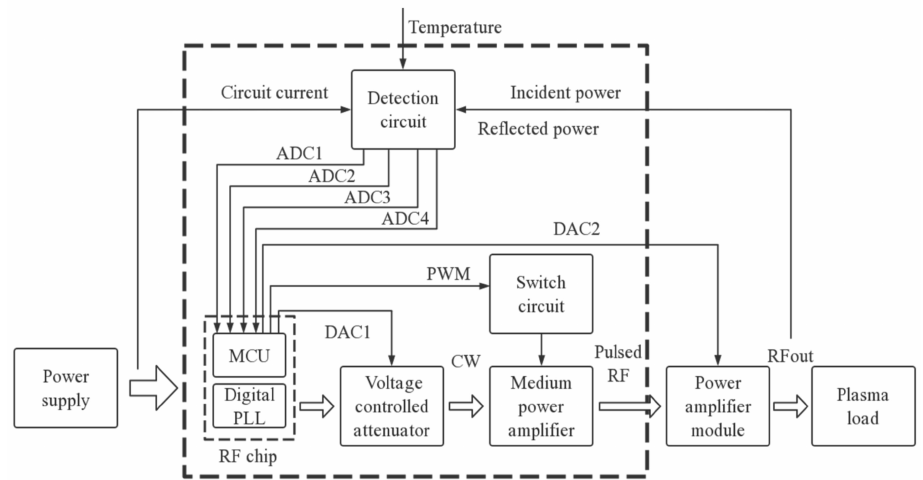
Figure 1. Structure of hardware circuit of the plasma lighting system.